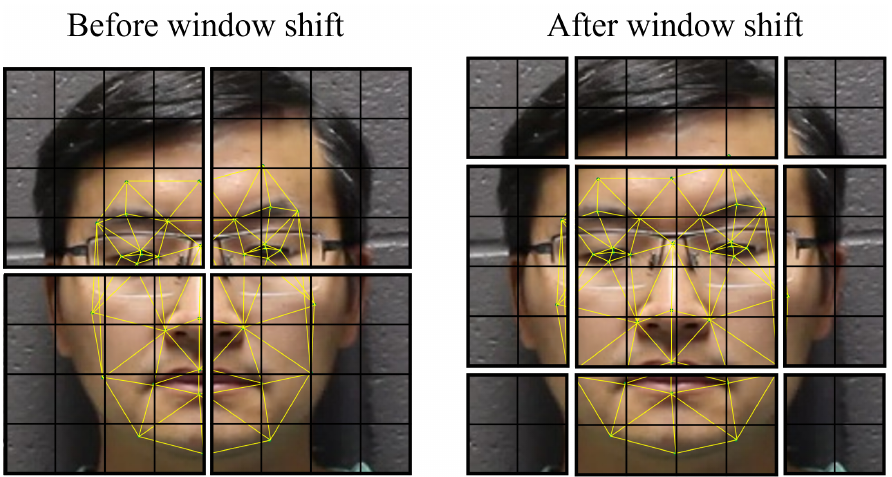
Figure 3. The hierarchical architecture allows the different layers to learn different parts of the facial geometry. The illustration is based on a window size of 7.